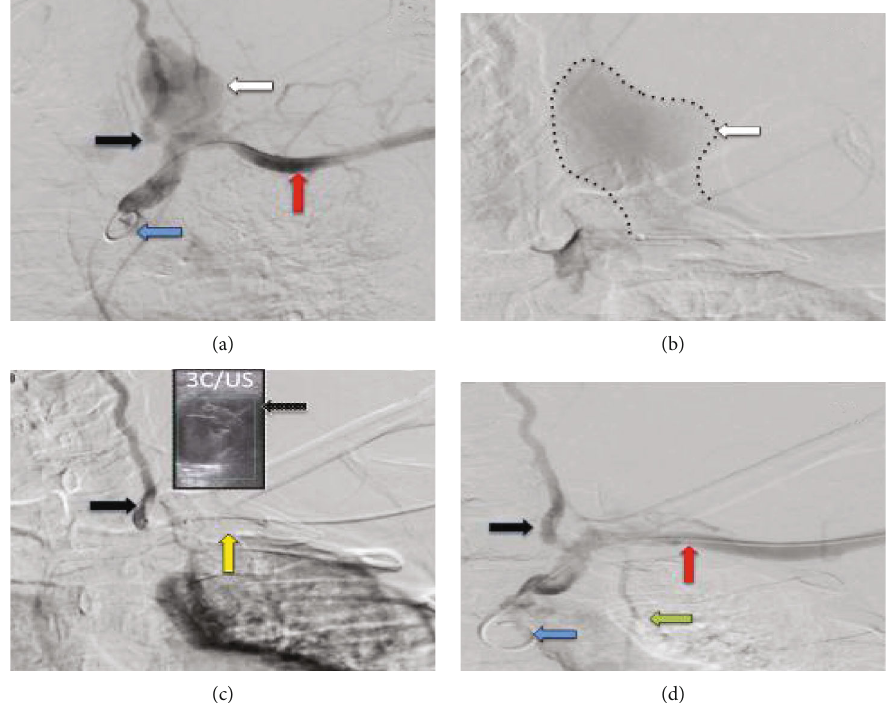
Figure 3: (a, b) Pigtail catheter (blue arrow) arteriogram showed pseudoaneurysm (white arrow) arising from the proximal part of the left subclavian artery (red arrow) distal to the origin of the left vertebral artery (black arrow). (c) Angioplasty balloon-tipped catheter (yellow arrow) covering the neck of the pseudoaneurysm. Bedside ultrasound documents the absence of the fl ow within the pseudoaneurysm by in fl ating the balloon, and injection of thrombin was done under ultrasound guidance ((c) and US). (d) Arteriogram after the thrombin injection shows no pseudoaneurysm, and it shows the left subclavian artery (red arrow), left vertebral artery (black arrow), and left internal mammary artery (green